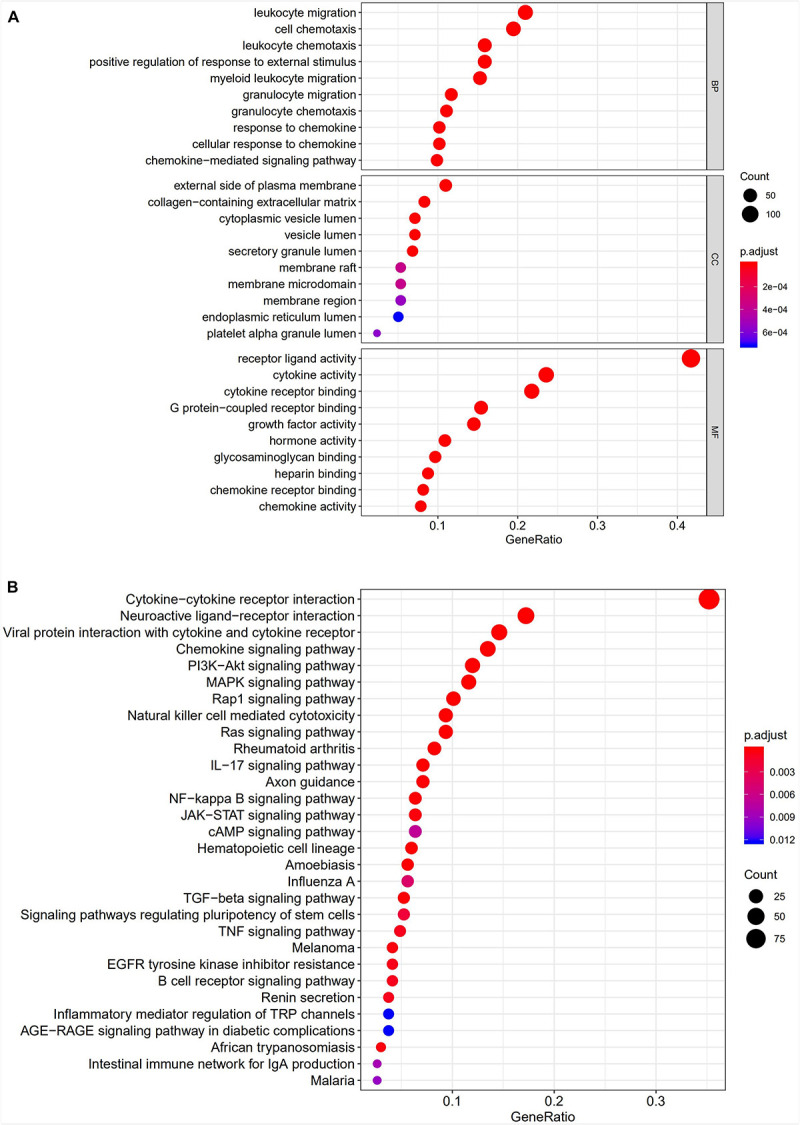
Gene functional enrichment analysis of immune-related DEGs. (A) The top 10 significant biological process, cellular component, and molecular function terms of the GO analysis. (B) The top 30 most significant KEGG pathways.